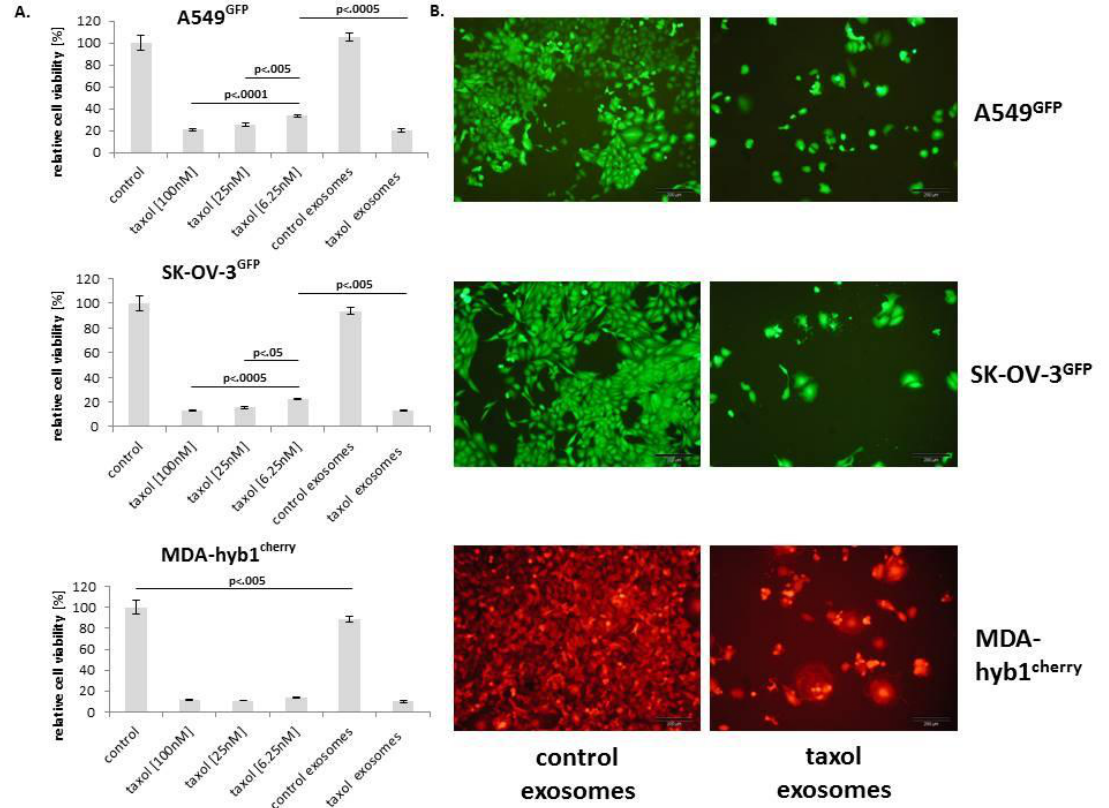
Figure 4. ( A ). Relative chemotherapeutic response of di ff erent human cancer cell populations, including A549 GFP lung cancer (upper panel), SK-OV-3 GFP ovarian cancer (middle panel), and MDA-hyb1 cherry breast cancer (lower panel) cells was tested for relative cell viability after exposure to di ff erent concentrations of taxol (100 nM, 25 nM, and 6.25 nM) compared to the appropriate steady state cancer cell populations cultured in the highest solvent concentration of taxol (control). Moreover, relative cytotoxic e ff ects of control exosomes (from steady state MSC cultured in the highest taxol solvent concentration) and of taxol exosomes (1:150 dilution derived from 10 µ M taxol-treated MSC) were evaluated. Following 72 h incubation of the di ff erent cancer cell population data were obtained from fluoroscan assays in triplicate and calculated as mean ± s.d. with corresponding controls set to 100%. Significance ( p ) was calculated by ANOVA followed by Tukey´s multiple comparisons test. ( B ) Fluorescence microscopy was performed for the di ff erent cancer cell lines following incubation with control exosomes (left micrographs) and compared to treatment with taxol exosomes (right micrographs) for 72 h. Bars represent 200 µm.